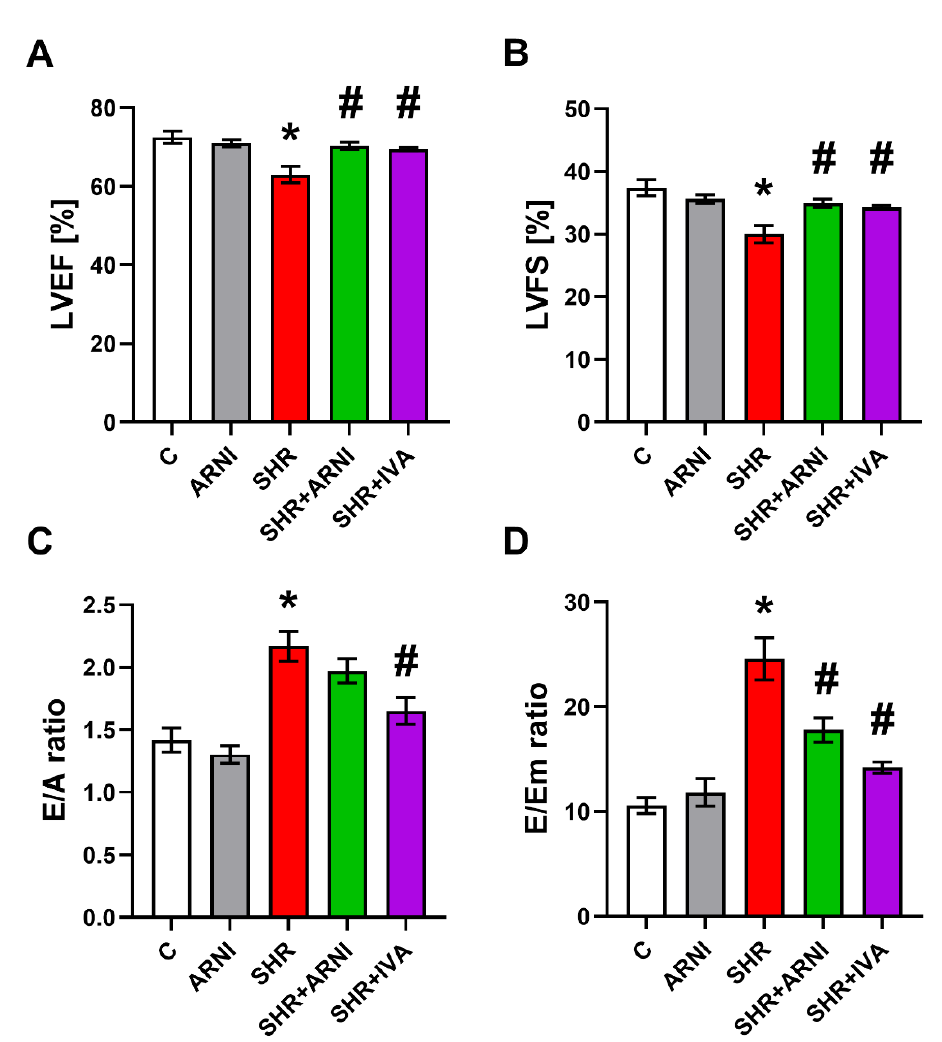
Figure 6. Effect of ARNI and ivabradine on left ventricular ejection fraction (LVEF) ( A ), left ventricular fractional shortening (LVFS) ( B ), the ratio of the diastolic transmitral peak early and late filling velocities (E/A ratio) ( C ), and the ratio of the diastolic transmitral peak early filling velocity and the maximal velocity of early diastolic wall movement wave at the level of mitral annulus (E/Em ratio) ( D ) in SHRs after six weeks of treatment. ARNI, sacubitril/valsartan; C, Wistar controls; IVA, ivabradine; SHRs, spontaneously hypertensive rats. Results are presented as means ± SEM. n = 7 per group. One-way, two-tailed ANOVA followed by multiple comparisons with a Bonferroni post-hoc test; * p < 0.05 vs. C; # p < 0.05 vs. SHR.